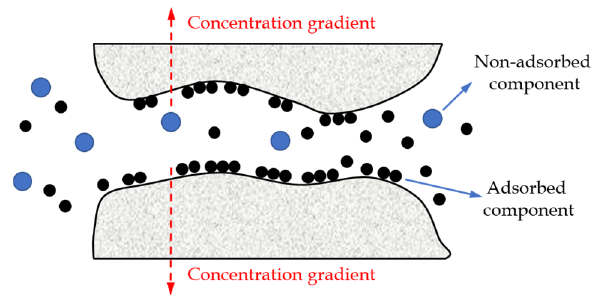
Figure 3. A schematic diagram of the surface diffusion. (3) Molecular sieving.